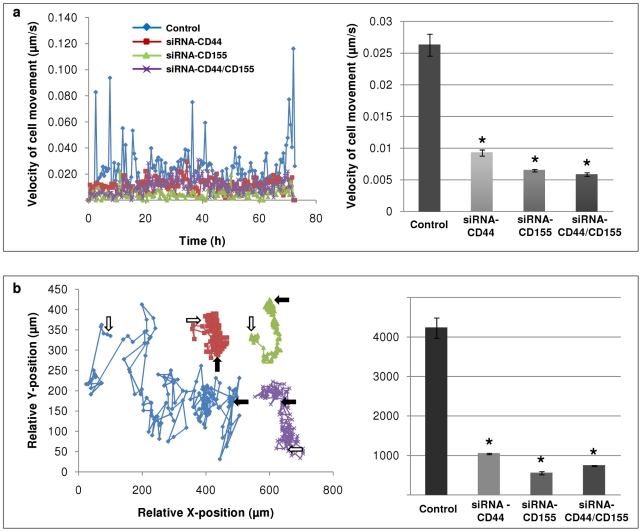
Reduced motility rate in CD44/CD155-KD SNB-19 cells.Non-targeting siRNA treated SNB-19 cells were used as a control. a, Velocity of cell movement (right panel) with cell tracking (left panel) analysed over a period of 72 h. The speed by which CD44/CD155-KD cells moved was significantly reduced. b, Total distance moved by cells (right panel) with cell tracking (left panel) over a period of 72 h. The distance travelled by CD44/CD155-KD cells was markedly decreased. Start position: white arrow; end position: black arrow. * indicates statistical significance compared to control.